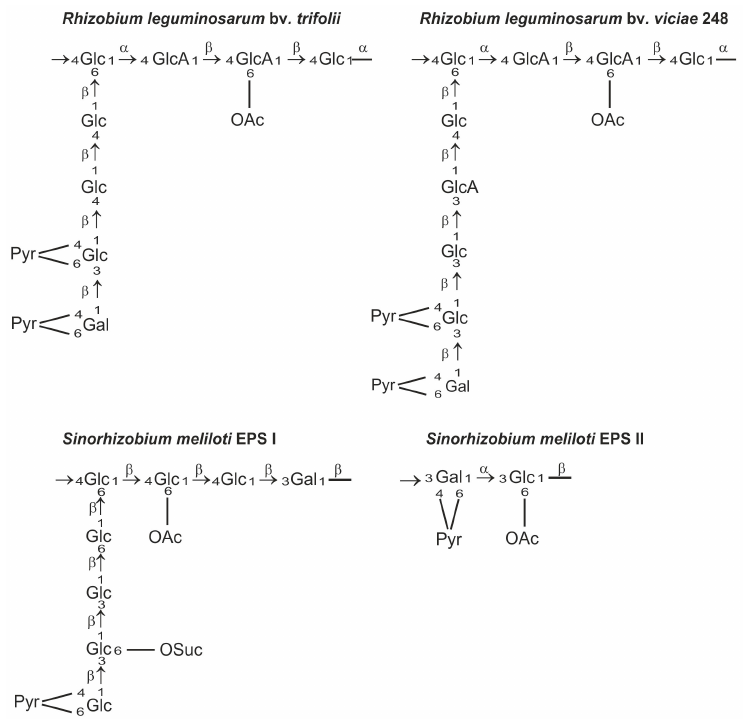
Figure 1. Selected chemical structures of exopolysaccharide (EPS) repeating unit of: Rhizobium leguminosarum bv. trifoli [50,51], Rhizobium leguminosarum bv. viciae [48], Sinorhizobium meliloti EPS I [52], Sinorhizobium meliloti EPS II [53]. Glc, glucose; GlcA, glucuronic acid; Gal, Galactose; OAc, acetyl; Pyr, ketal pyruvate; OSuc, succinyl groups.